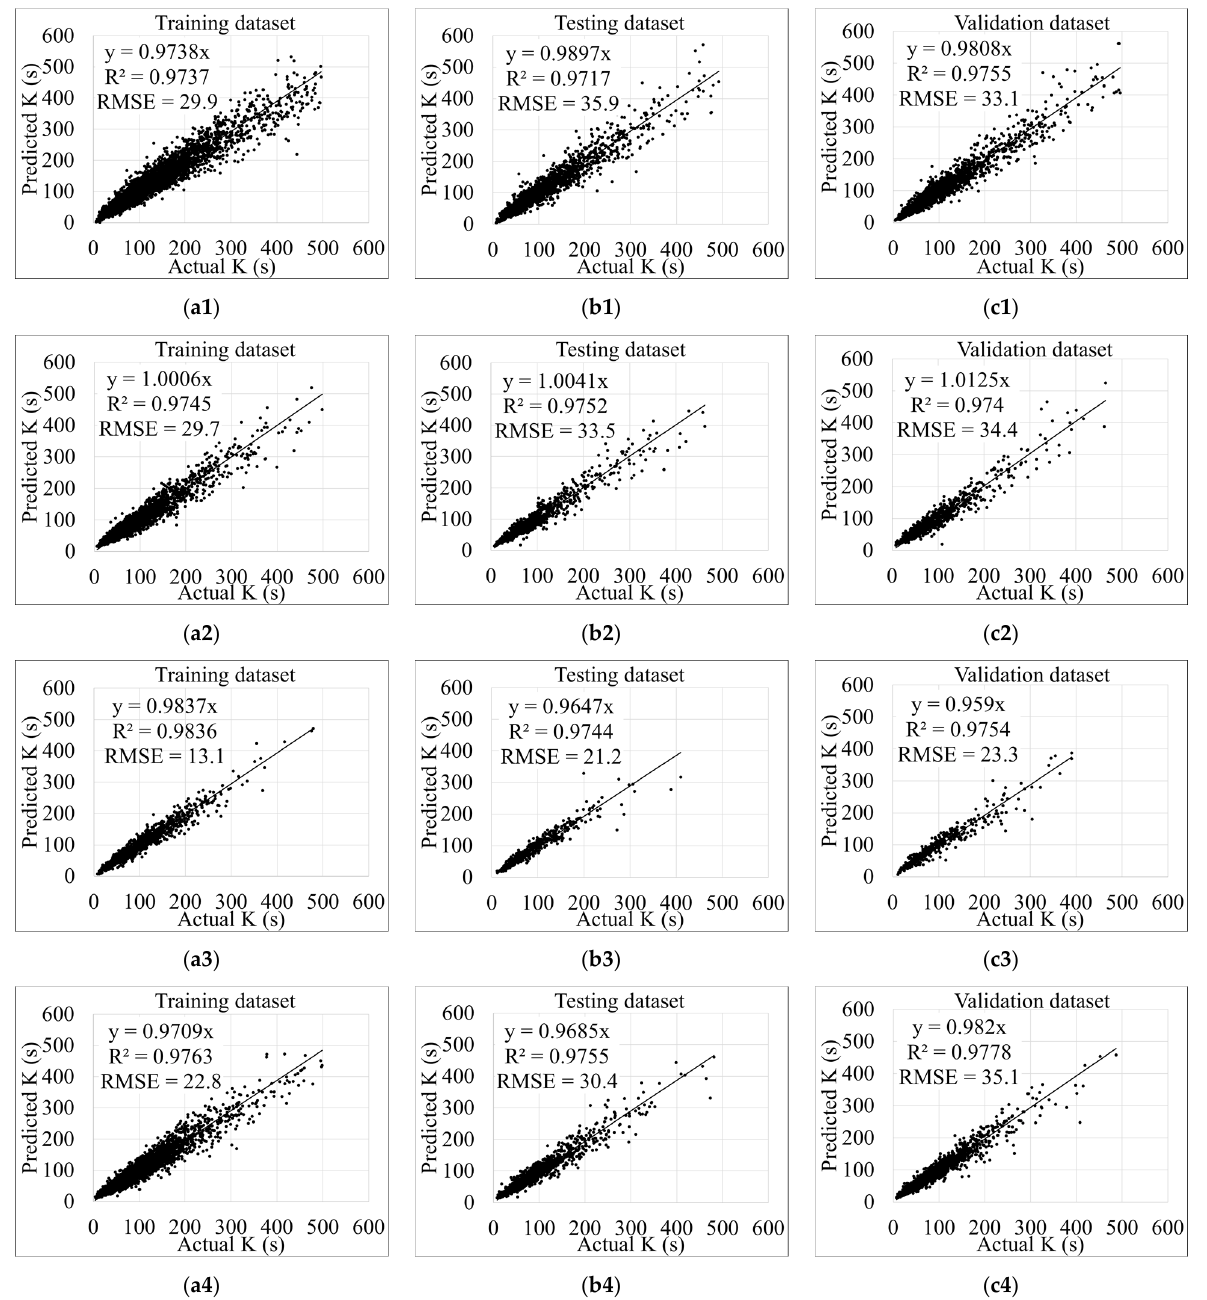
Figure 6. Predicted versus computed stop penalty of light-duty vehicle (LDV) groups: ( 1 ) LDV1, ( 2 ) LDV2, ( 3 ) LDV3, ( 4 ) LDV4, ( a ) training data, ( b ) testing data, ( c ) validation data.